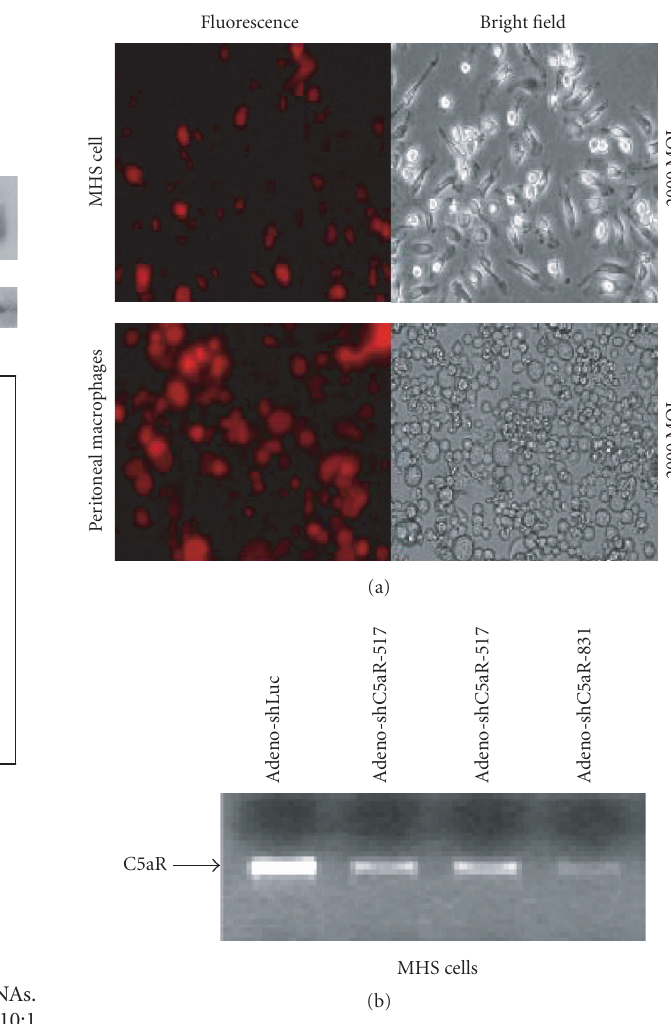
Figure 4: In vitro silencing by siRNA-expressing adenovirus. Both MHS cell and peritoneal macrophages were infected with 2000MOI of adenovirus. (a) Sixty hours after infection, expression of dsRed protein in the cells was visualized by fluorescence microscope. Virus infection e ffi ciency was examined by comparing the fluorescence images (left) and the bright field images (right). (b) Silencing e ff ects of adenovirus-expressed siRNAs were examined by one-step RT- PCR as described in Material and Method. Adeno-luciferase siRNA was used as